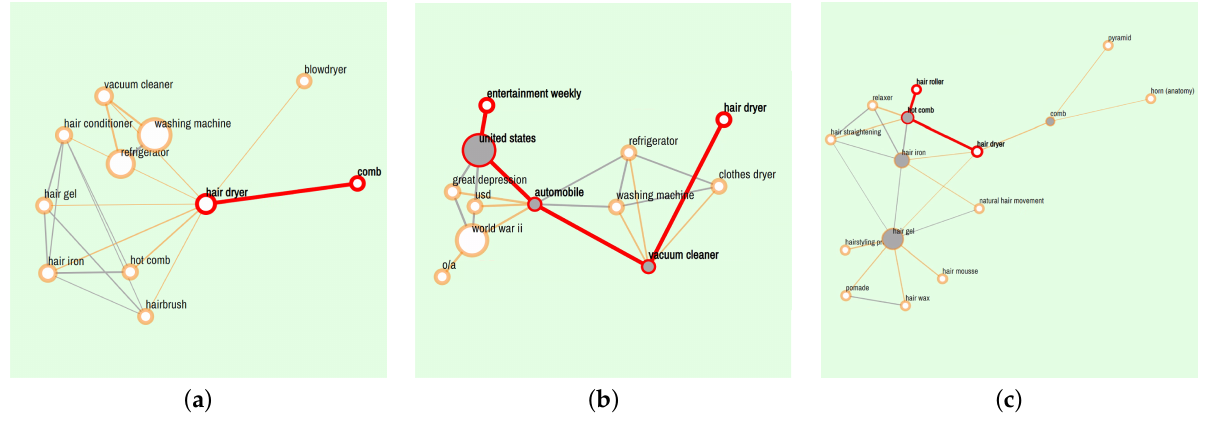
Figure 8. The examples of concepts retrieved by “Explore”: ( a ) “Explore-General” results with one step for “hair dryer”; ( b ) “Explore-General” results with two steps for “hair dryer”; ( c ) “Explore- Specific” results with two steps for “hair dryer”. Table 10. The paths between the inspiring concepts and “hair dryer” retrieved by “Search